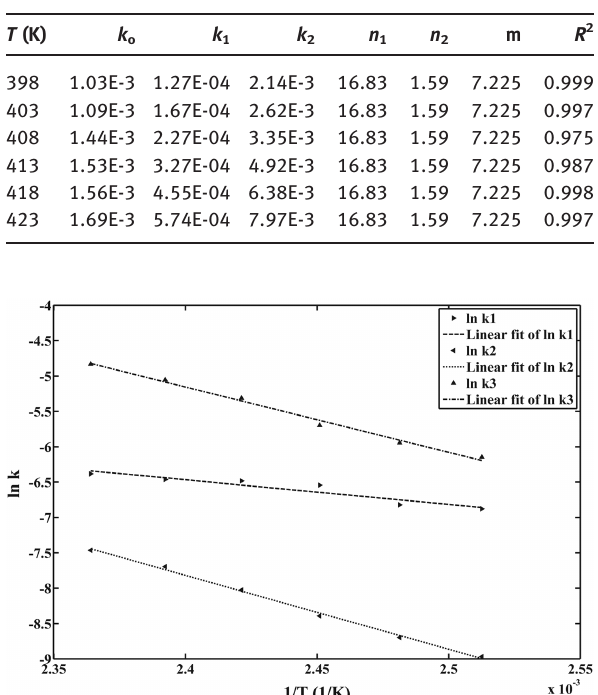
Table 1: Model parameters at different temperatures.